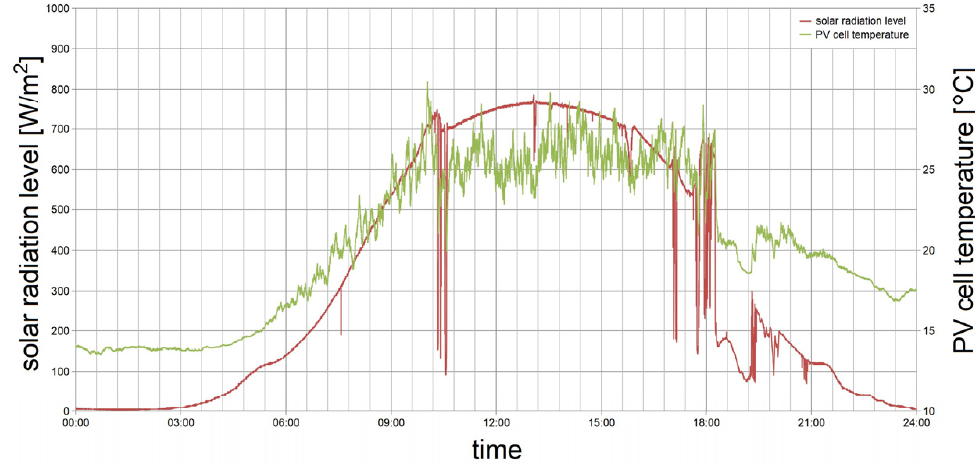
Figure 11. λ and T c for 16 June.